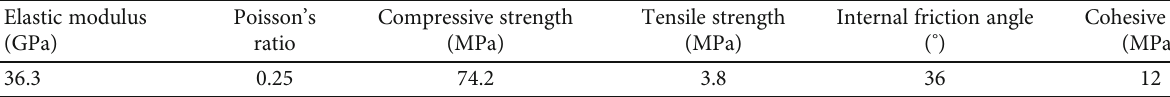
Table 6: Mechanics parameters of carbonate rock in Tahe oil fi